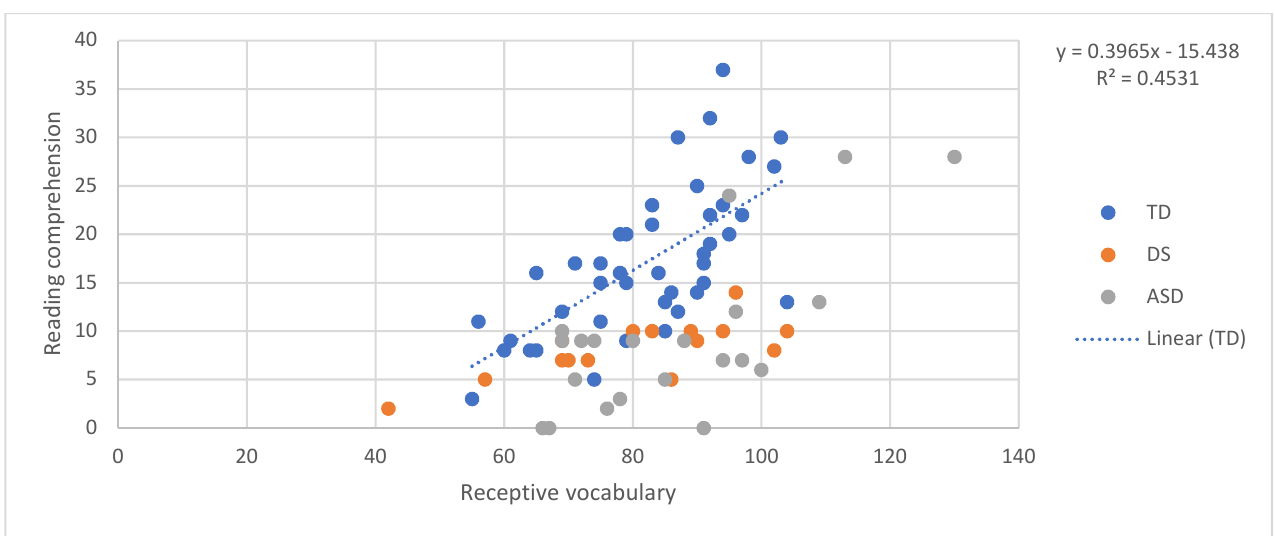
Figure 2. Non-word reading accuracy predicting reading comprehension.